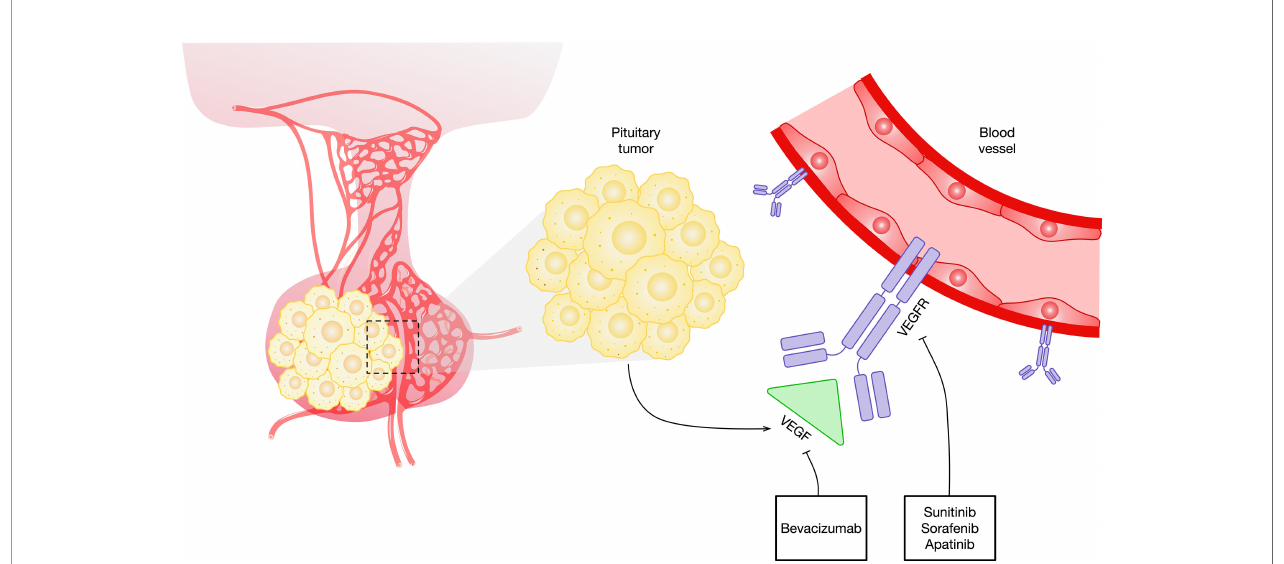
FIGURE 1 | Schematic representation of antiangiogenic agents that target the VEGF and VEGF signaling pathways in pituitary tumors. VEGF, vascular endothelial growth factor; VEGFR, vascular endothelial growth factor